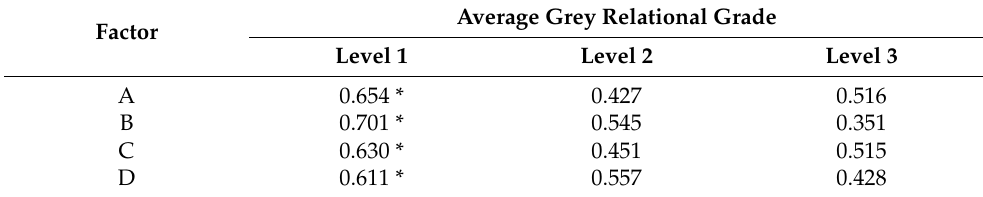
Table 5. Average grey relational grade at different cutting parameters. Factor